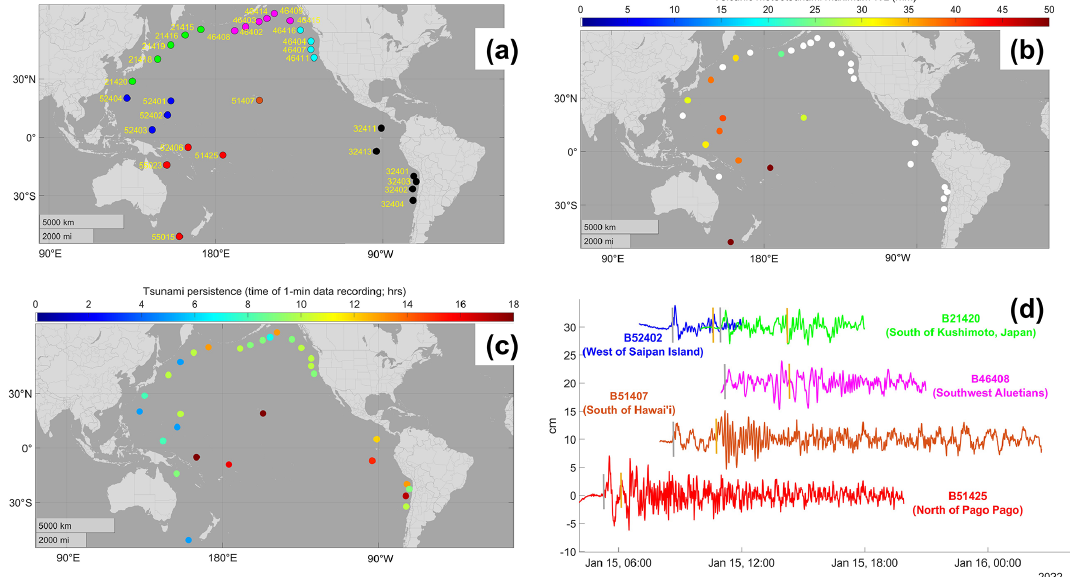
Figure 2. Pacific deep-water NDBC buoys used to detect the VMT and marine tsunami of the Tonga event. (a) Buoy locations and NDBC buoy designation numbers (Table S1), with colors used to show Pacific regional delineation (red: southwest; orange: central; dark blue: west; green: northwest; magenta: north; cyan: northeast; black: southeast). (b) Maximum VMT-induced WL (mm) detected at each buoy according to color scale at top of map. White markers indicated that the VMT was not detected at the buoy. (c) Persistence time of the tsunami signal at each buoy, representing the length of time that each buoy recorded at 1min resolution (h). (d) WL response to the VMT and marine tsunami at five deep-water buoys in the Pacific using same color scheme as (a) . Two buoys are given on the same line (B52402 and B21420) since their physical locations were on nearly the same great circle path from Tonga; other buoys are offset 10cm vertically from each other. VMT arrivals based on a theoretical travel time of 1115kmh − 1 are indicated by gray vertical lines, and marine tsunami arrivals based on an average travel time of 700kmh − 1 are indicated by orange vertical lines. Maps made in MATLAB using data from Natural Earth.